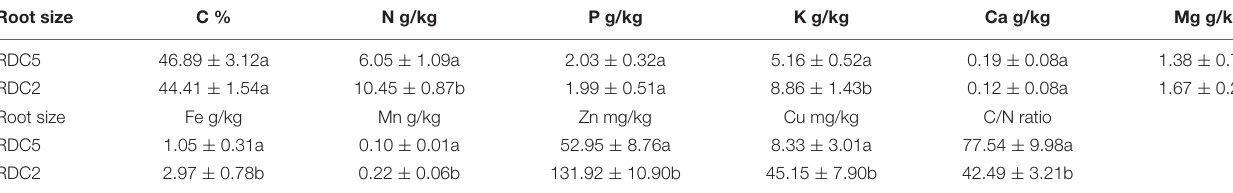
TABLE 3 | Initial concentration of nutrients in litter from bamboo roots of different diameters.